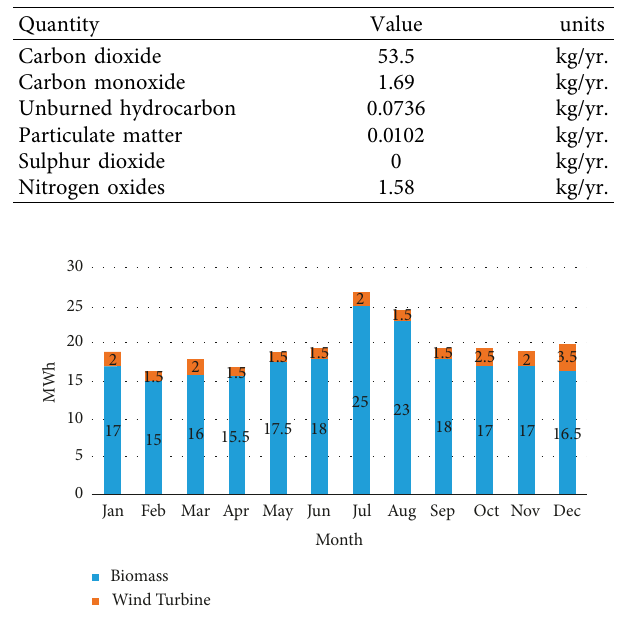
Table 5: Properties data of the system under study for Scenario 1.